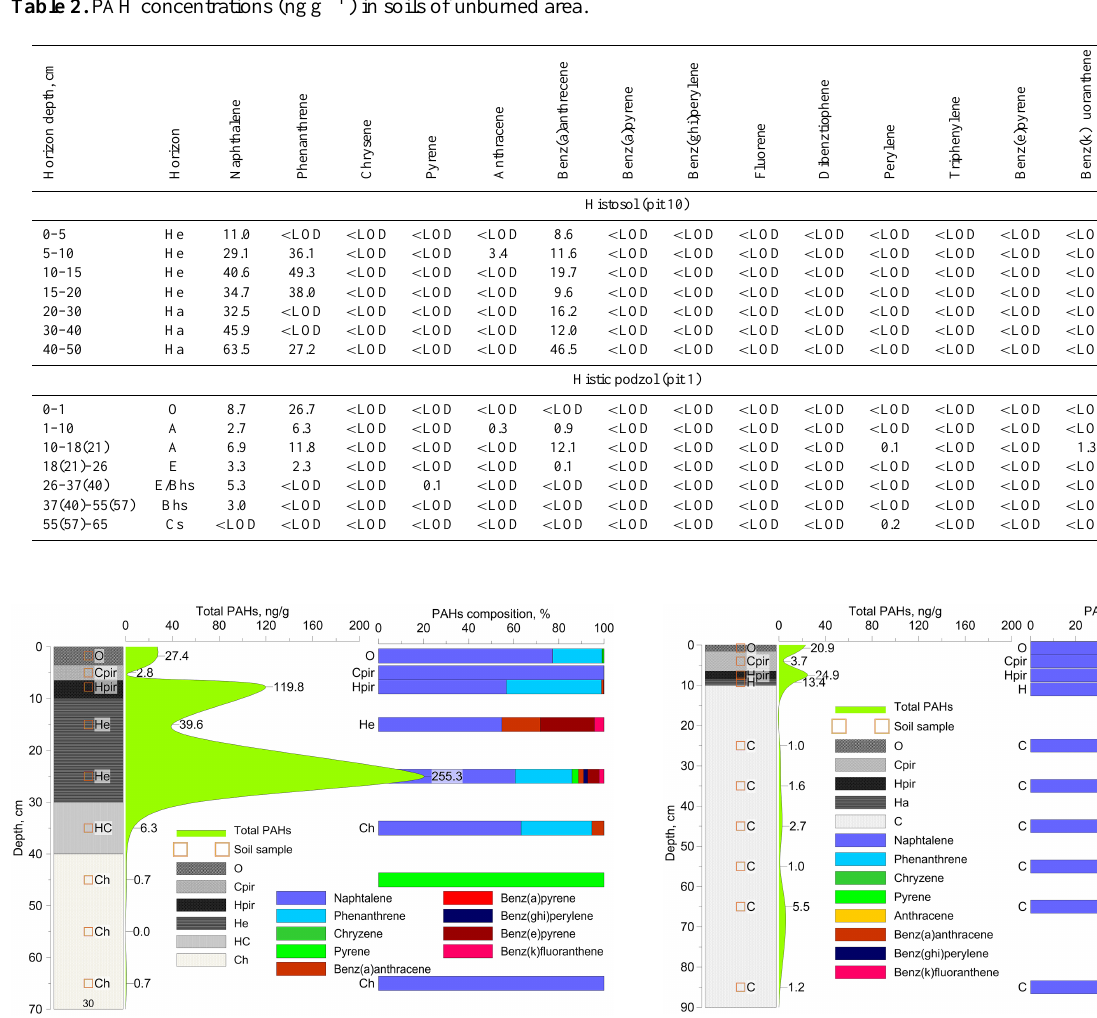
Figure 7. The profile distribution and composition of PAHs in post- fire histosol in the case of almost complete burning out of the or- ganic layer (pit